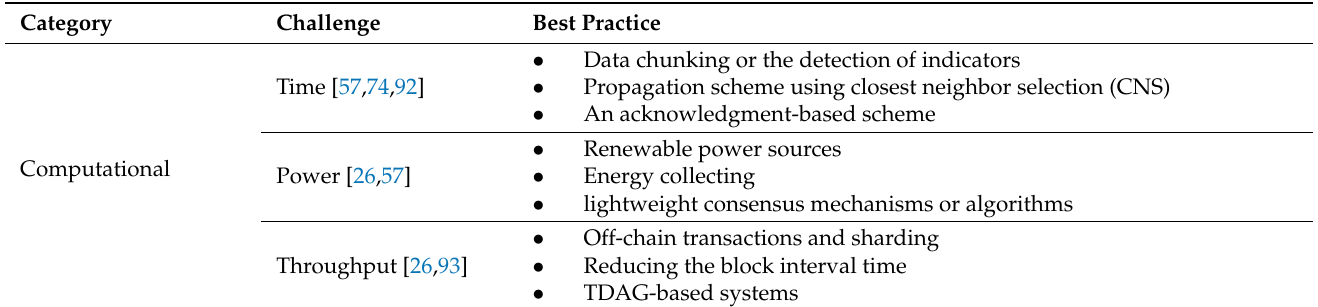
Table 10. Recommendations for reducing the negative impact of computational